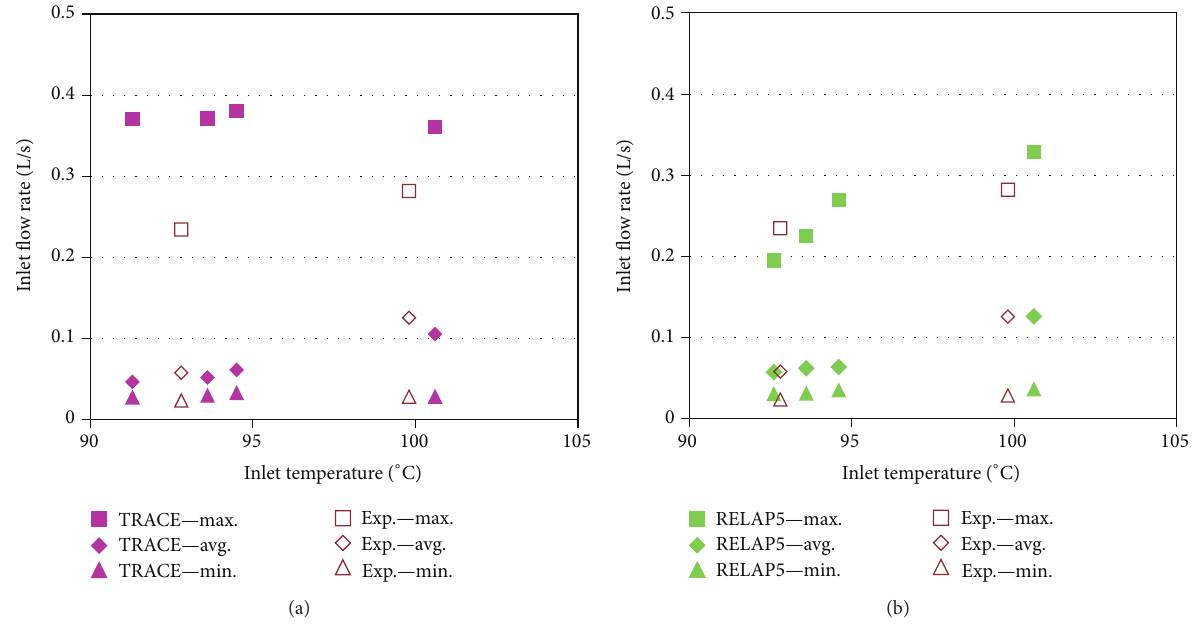
Figure 13: Inlet flow rate sensitivity to the inlet temperature: (a) TRACE and (b) RELAP5.